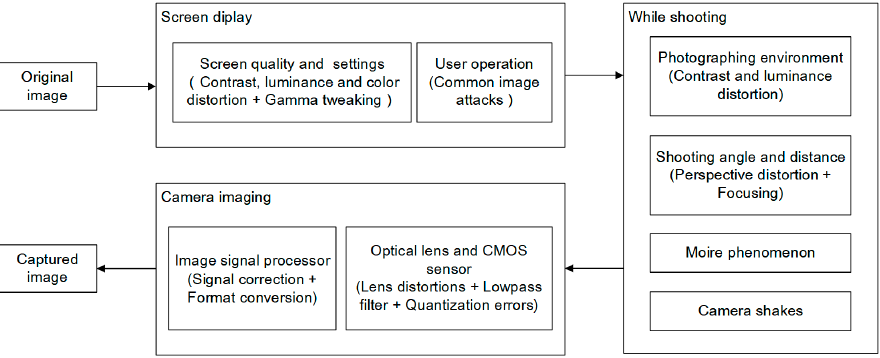
Figure 1. Various processes and corresponding distortions in screen-cam process.